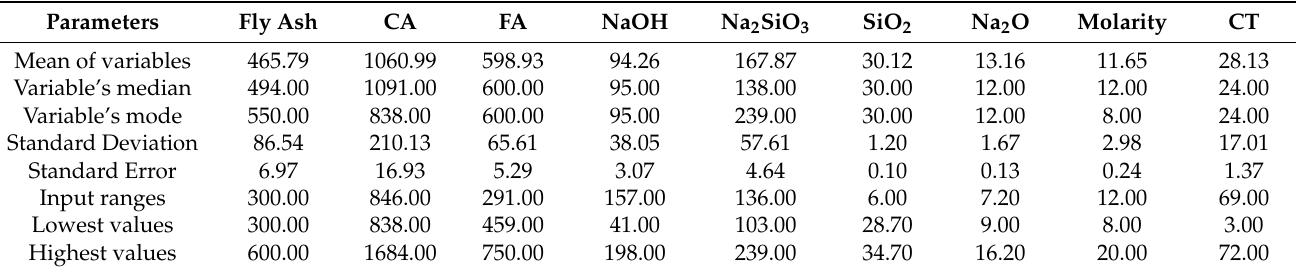
Table 1. Descriptive statistics of the input